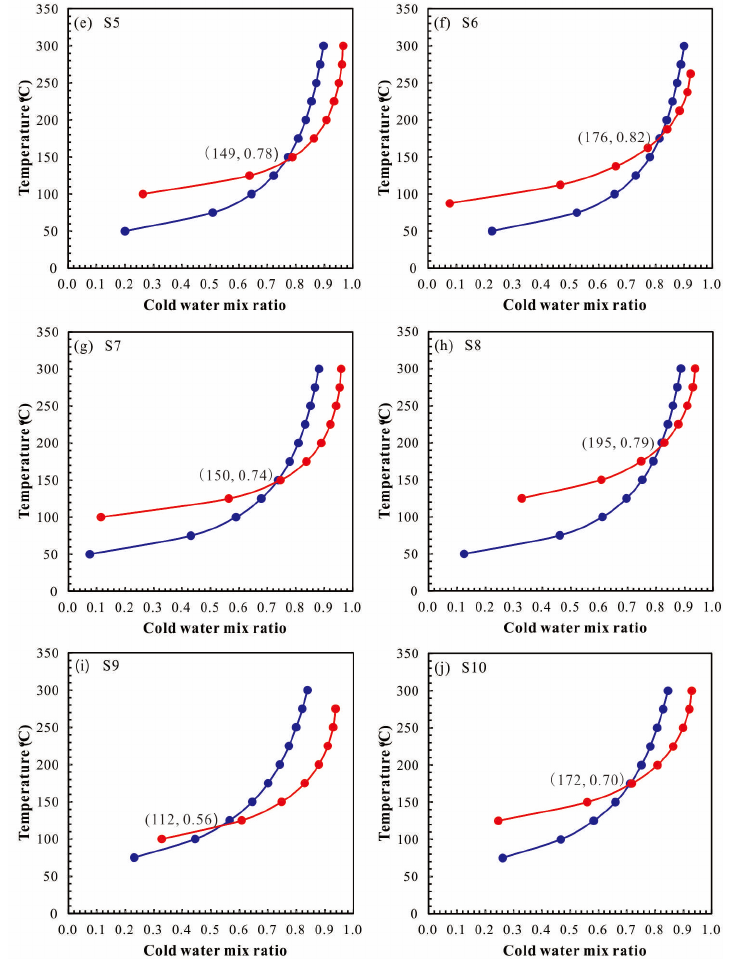
Figure 11. Relations between fraction of cold water and temperature in the mixing model. Blue curve = enthalpy, red curve =